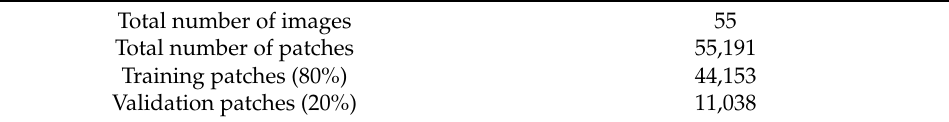
Table 1. Train and validation distribution.